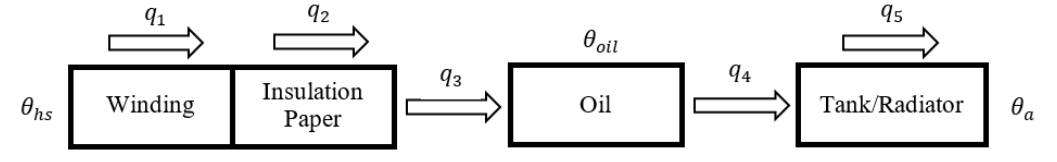
Figure 1. Pathway of energy in transformers.